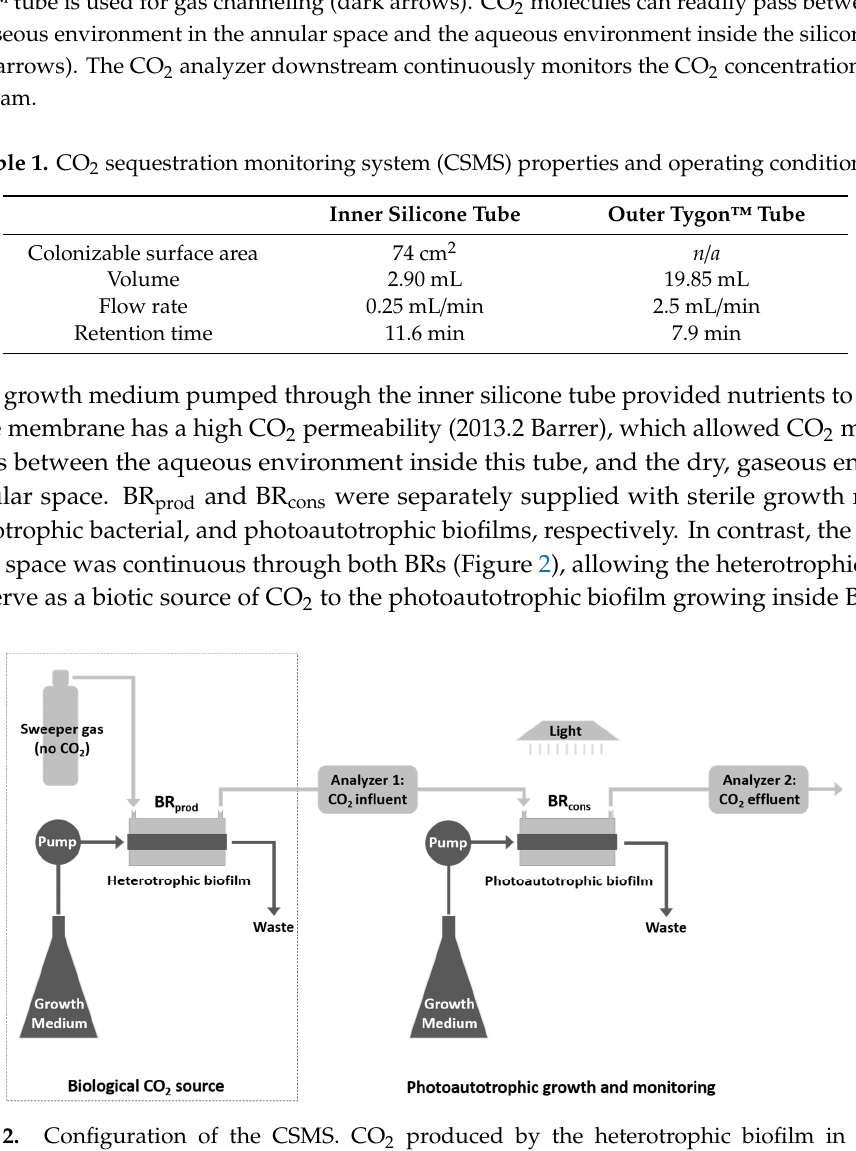
Figure 2. Configuration of the CSMS. CO 2 produced by the heterotrophic biofilm in BR prod (CO